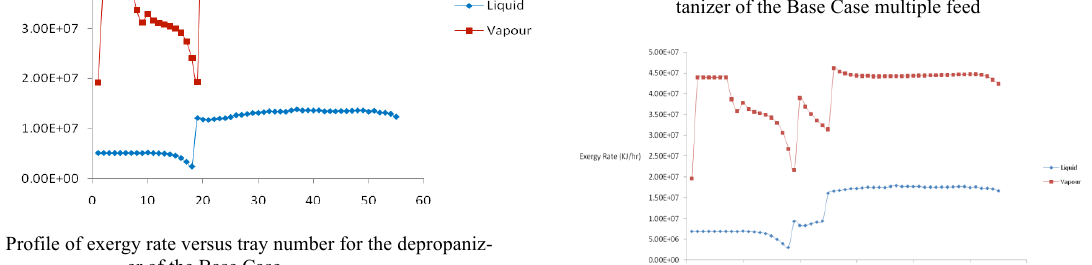
Figure 8. Profile of enthalpy rate versus tray number the for Debu- tanizer of the Base Case multiple feed